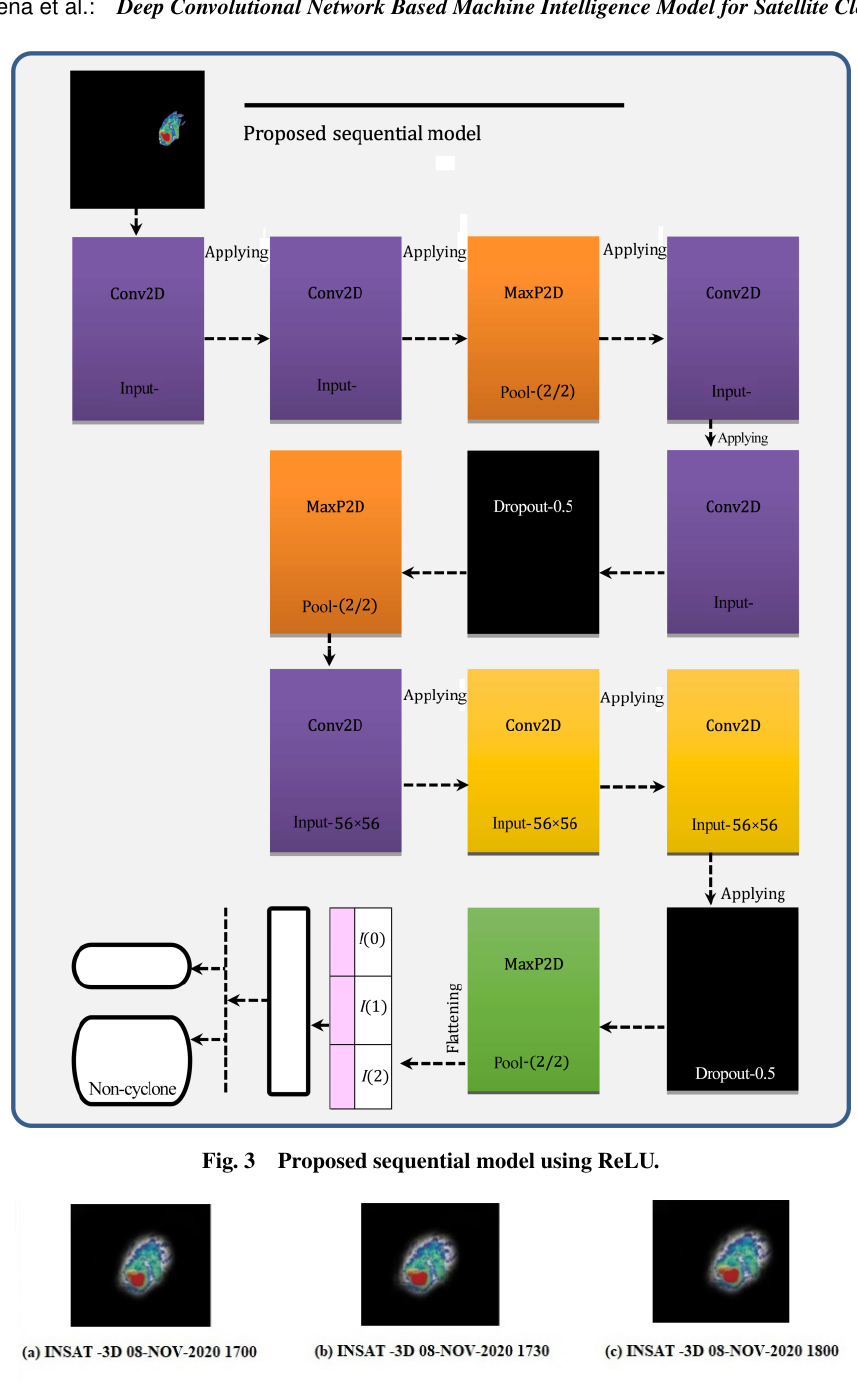
Fig. 4 Bulbul cyclone images in the dataset (sample images) [20,21]